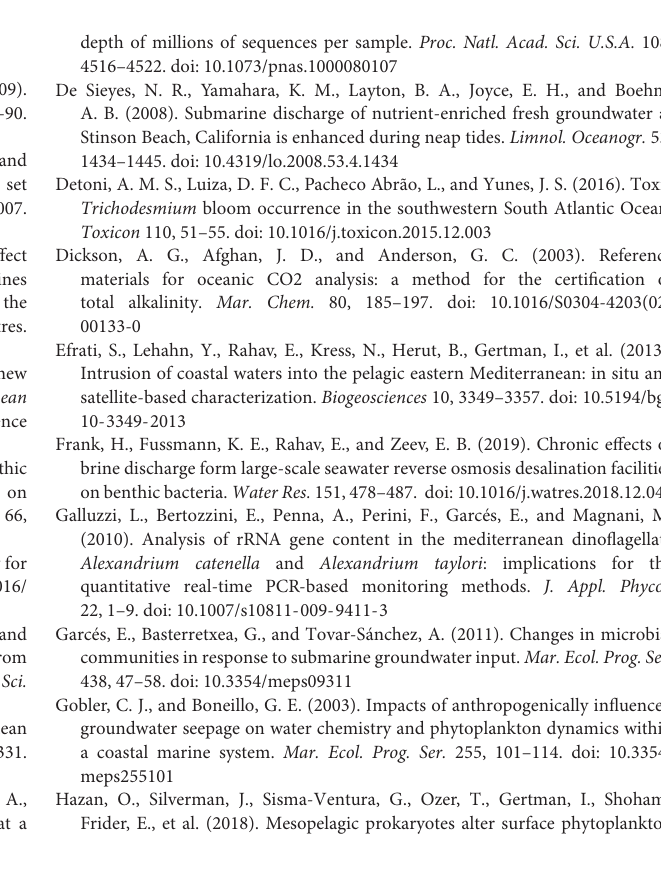
Supplementary Figure 1 | Multi-annual monthly averages of NO x (A) , Si(OH)4 (B) , PO 4 (C) , and total alkalinity normalized to a constant salinity of 39.234 PSU (D) in the surface water at the edge of the erosion platforms in Achziv (green) and Tel Shikmona (white) during the period 2011–2019. The error bars represent the standard deviations of 6–9 measurements made at each site during each month throughout the monitoring